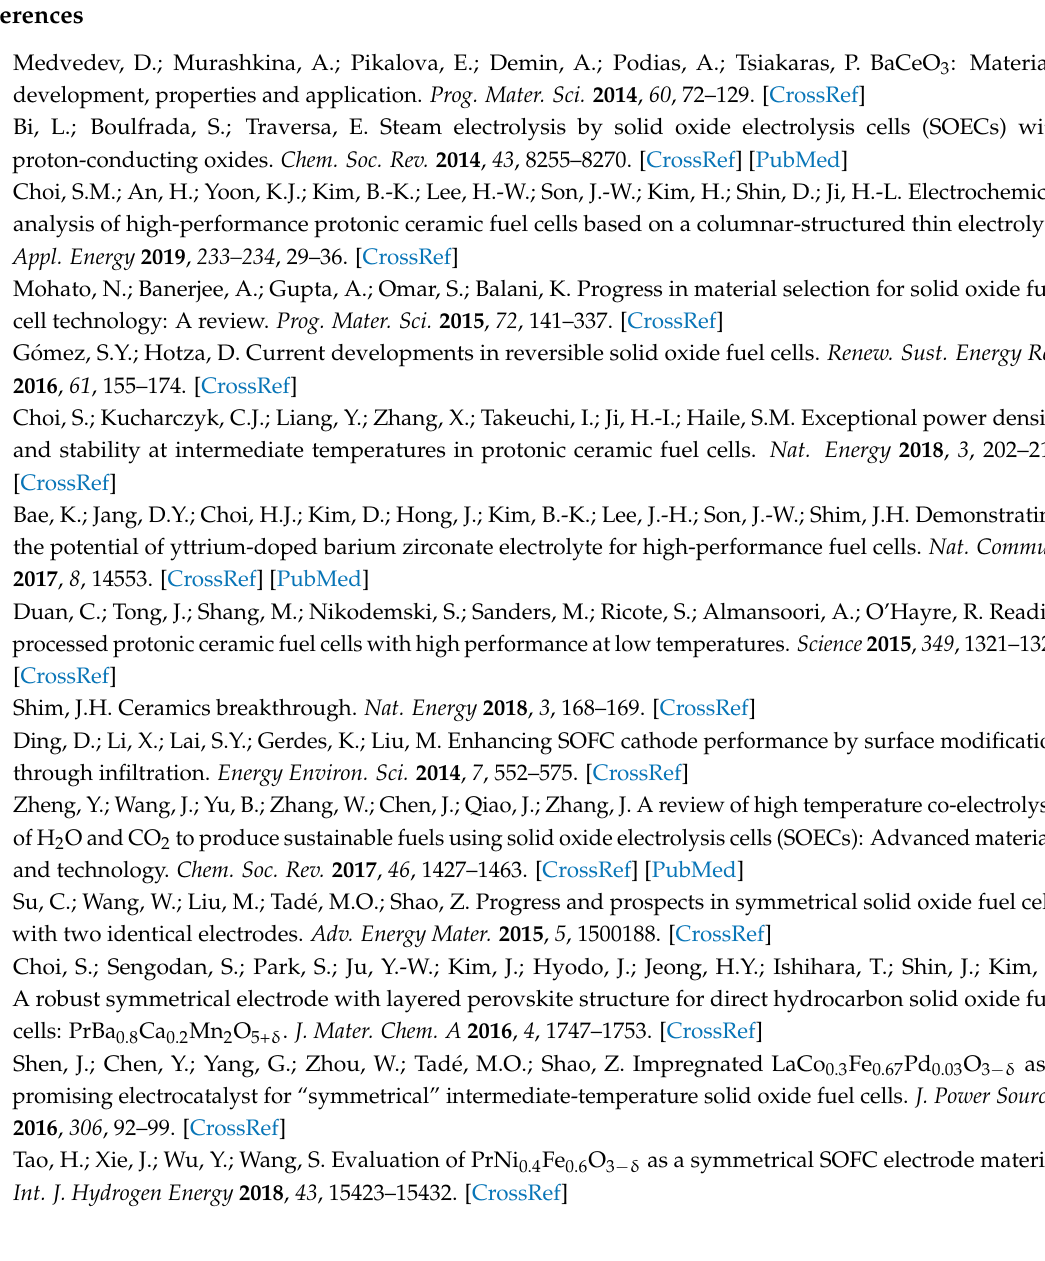
Figure A5. DRT results for the impedance spectra measured for the PCC at 750 °C under OCV conditions at different pH 2 O values in hydrogen atmosphere (p’’H 2 O in air is equal 0.5 atm).